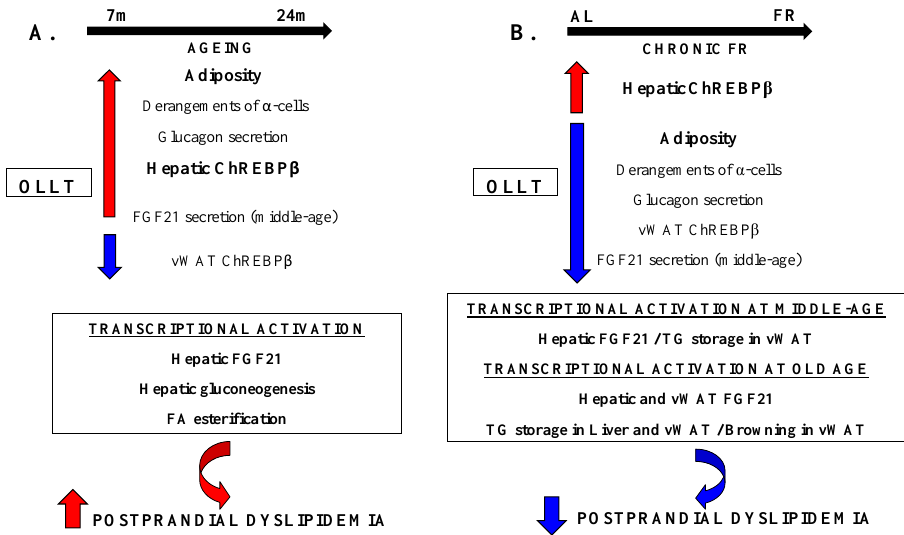
Figure 11. Scheme summarizing the suggested mechanisms about the effects of ageing and moderate chronic food restriction on postprandial dyslipidemia after an oral lipid loading test (OLLT). ( A ) The progression of postprandial dyslipidemia with ageing, in Wistar rats, is associated to increased hepatic ChREBPβ activity and adiposity, as suggested by the gene expression analysis through increased gluconeogenesis and FA esterification in the liver. ( B ). Moderate chronic FR ameliorates postprandial dyslipidemia in middle-aged (7-month-old) and middle-old-aged (24-month-old) Wistar rats, through different mechanisms. In the 7-month-old rats, FR stimulated the transcriptional response leading to an increase in TG accumulation in vWAT, while in the 24-month-old rats, FR stimulated TG accumulation in both liver and in vWAT, and the activation of the browning program in vWAT.